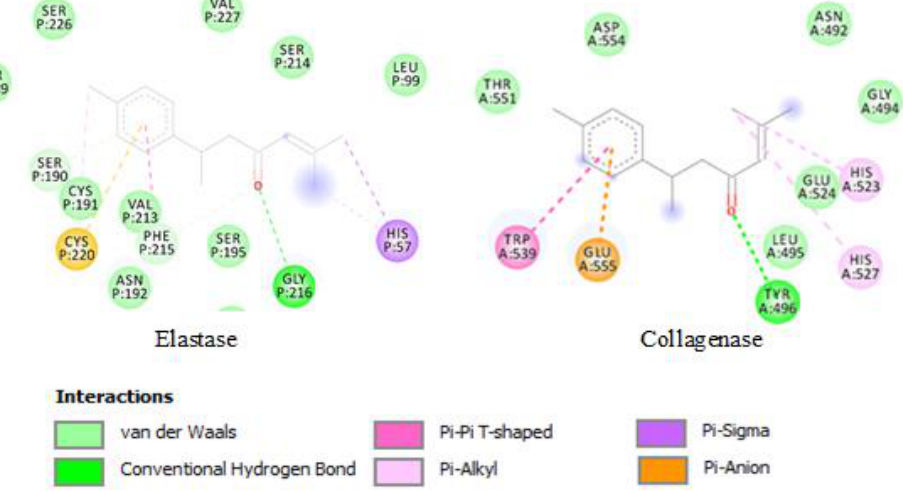
Figure 1. Shows intramolecular interactions of turmerone displaying the highest binding affinity with the studied